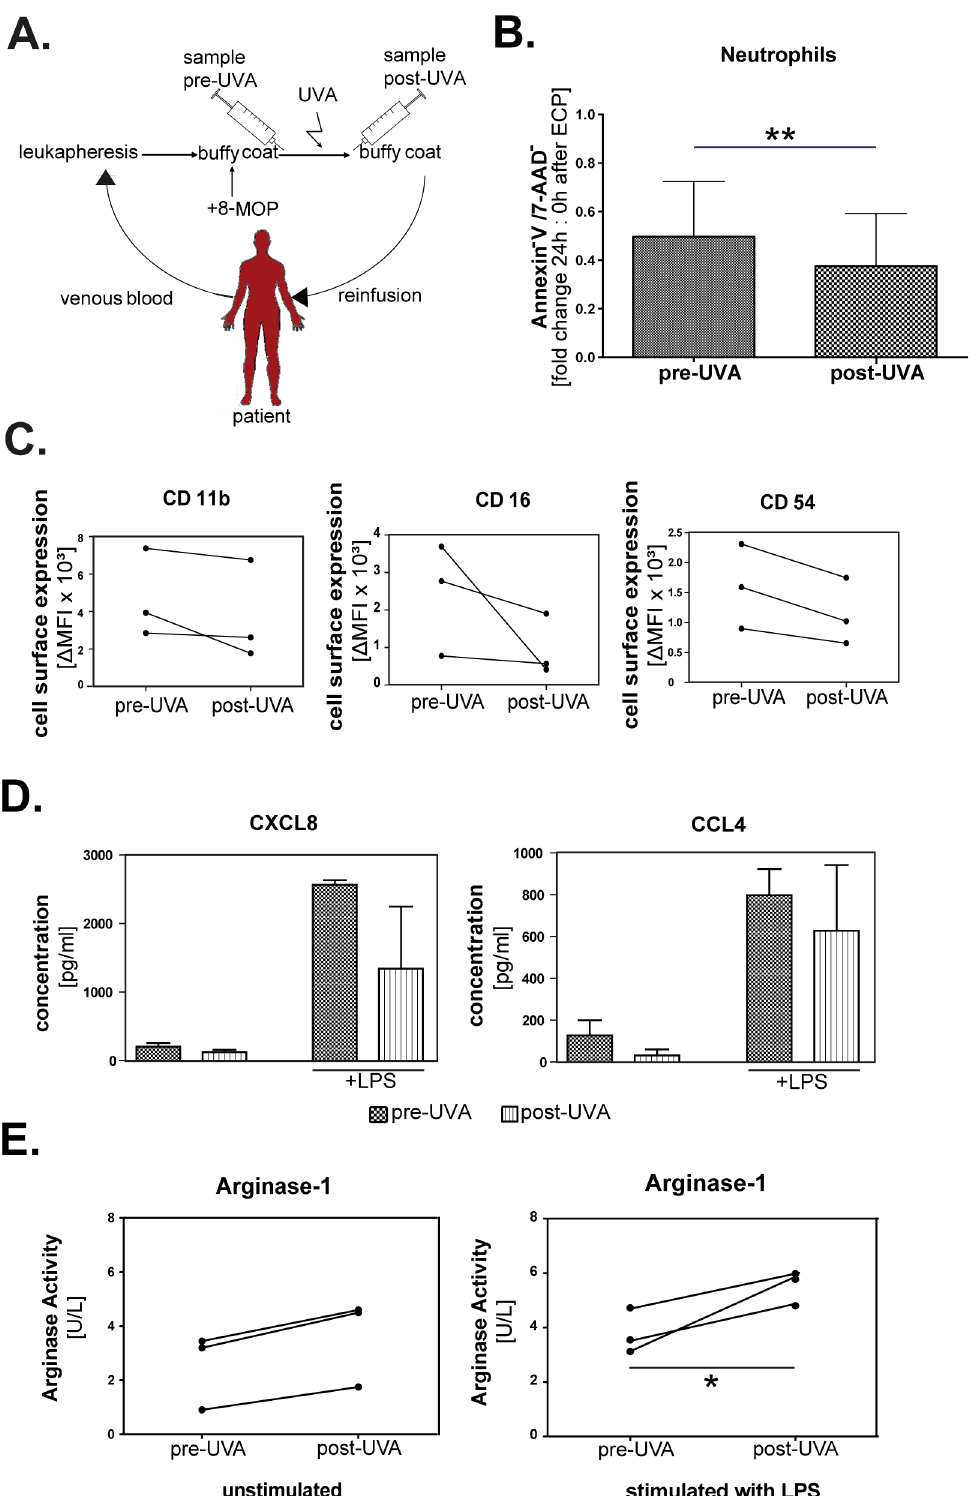
Fig 4. Reduced activation and increased extracellular arginase-1 activity in chemoirradiated neutrophils from buffy coat of cGVHD patients. (A) Neutrophil granulocytes and mononuclear cells substituted with 8-methoxypsoralen (8-MOP) were obtained from the buffy coat of patients with cGVHD treated with a Therakos UVAR XTS device before (pre-UVA) and after (post-UVA) irradiation. (B) Neutrophils of the buffy coat before and after irradiation with